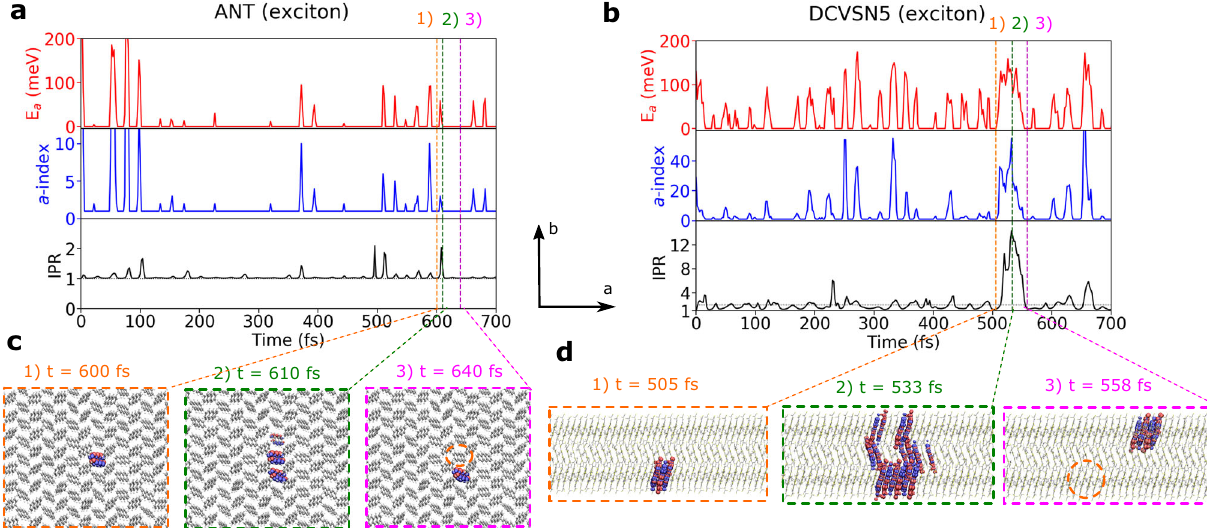
Fig. 3 Hopping and transient delocalization mechanisms for exciton transport. Panels a , b show time series along a single representative FE-SH trajectory for ANT and DCVSN5, respectively. Top panels: energy of the active potential energy surface on which the nuclear dynamics is run in FE-SH simulations, E a (red lines), referred to the ground state. Middle panels: index of the active exciton band state, a (blue lines, index a = 0 corresponds to the ground state which is the bottom of the excitonic band). Bottom panels: IPR( t ), Eq. (8), of the excitonic wavefunction Ψ ( t ), Eq. (3), (black lines) and average IPR of Ψ ( t ) over the swarm of FE-SH trajectories (horizontal dashed gray lines). Note the correlation between the intra-band excitations, i.e., eigenstate index a , excitation energy, and IPR( t ) of Ψ ( t ). Panel c depicts a typical nearest-neighbor hopping event of the exciton in ANT and panel d a representative transient delocalization event of the exciton in DCVSN5. Notice the much larger spatial displacement from the initial position (indicated with orange circles) in the latter case. The excitonic wavefunctions in panels ( c , d ), Ψ ( t ), Eq. (3), are represented by isosurfaces of the transition density on each molecule scaled by the expansion coef fi cient u l . The transition density is approximated, for visualization purposes, by the conjugated product of HOMO and LUMO